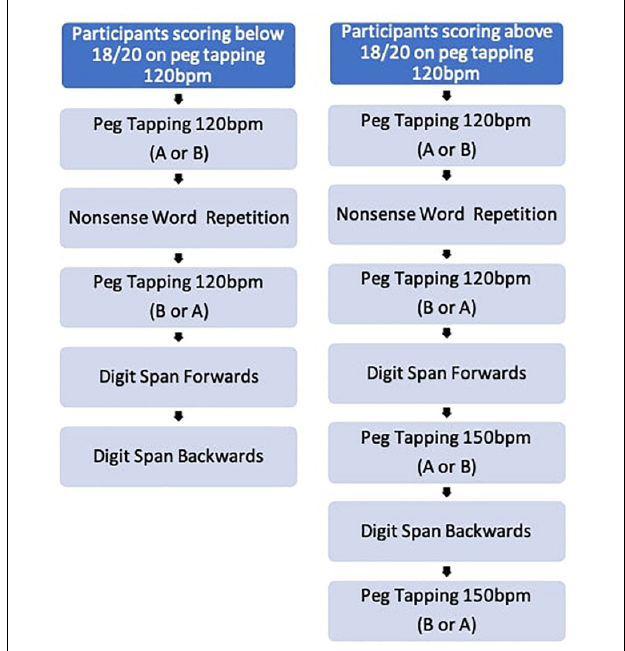
FIGURE 1 | Task procedure.